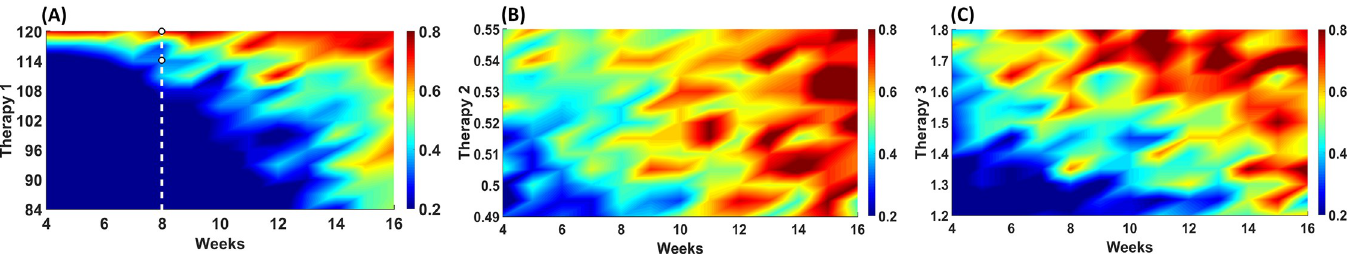
Fig 8. Probability of developing T1D based upon different targeted therapeutic strategies. The horizontal axes represent the administered time of a single dosage during simulation runs. Regions with red color represent a higher incidence of diabetes, and regions with blue color represent a lower incidence of diabetes. (A) Therapy 1 denotes the strategy that reduces the longevity of CTLs in islets. (B) Therapy 2 is described as an intervention that inhibits DC infiltration into islets. (C) Therapy 3 denotes a strategy that mitigates the binding process of na ï ve CD8 + T cells on DCs. Therapeutic interventions were implemented based upon single dosage regimens starting at week 4 to week 16. Two black circles filled white in Panel (A) show the change in T1D occurrence in Therapy 1 when the lifespan of CTLs was reduced from 120 hours to 114 hours at week 8.